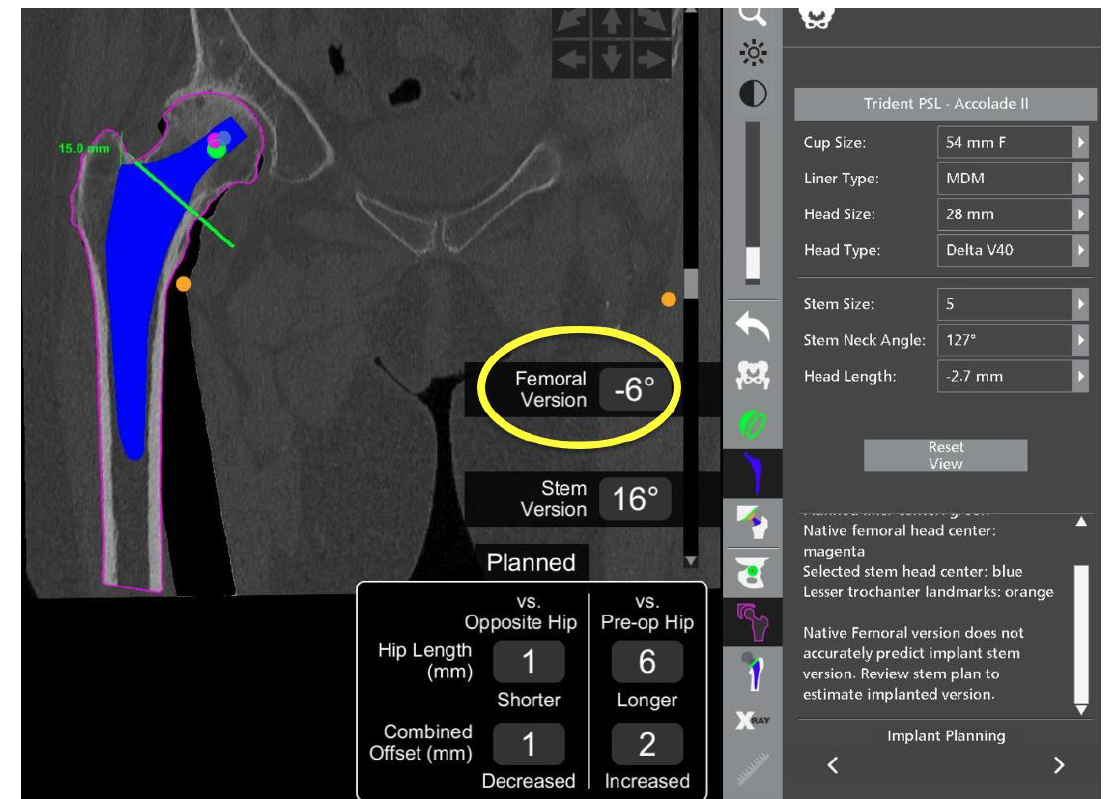
Figure 7. Native femoral version is −6 degrees (yellow circle)